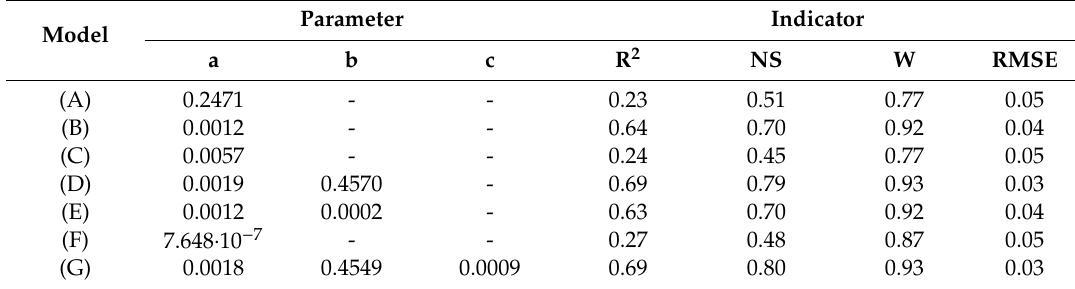
Table 6. Parameters a, b and c of the mass transfer model and goodness-of-fit indicators. Model